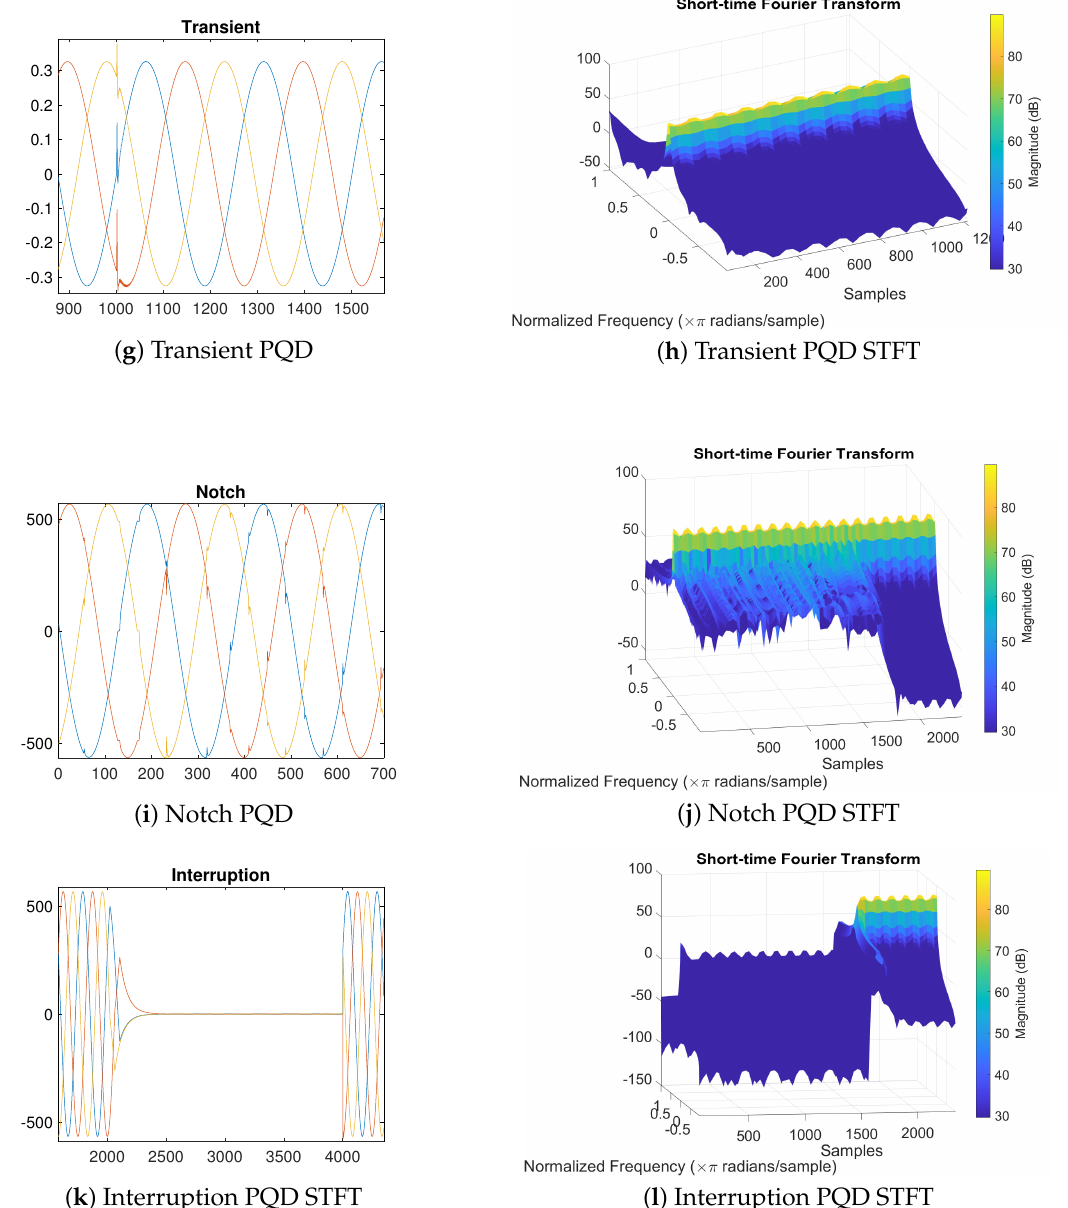
Figure A2. Disturbance plots (Left) and the STFT (Right). ( a , b ) Sag, ( c , d ) Swell, ( e , f ) Harmonics, ( g , h ) Transient, ( i , j ) Notch, ( k , l )